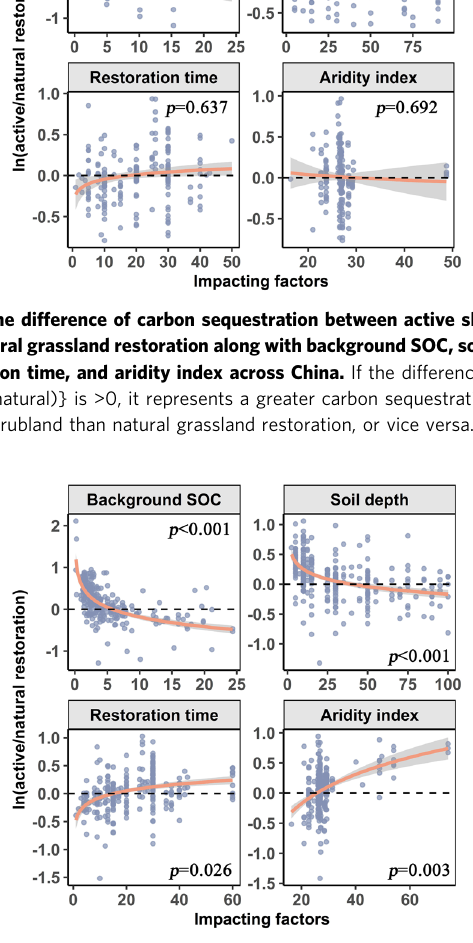
Fig. 5 The difference of carbon sequestration between active forest and natural grassland restoration along with background SOC, soil depth, restoration time, and aridity index across China. If the difference {ln (active/natural)} is >0, it means a greater carbon sequestration by active forest than natural grassland restoration, or vice